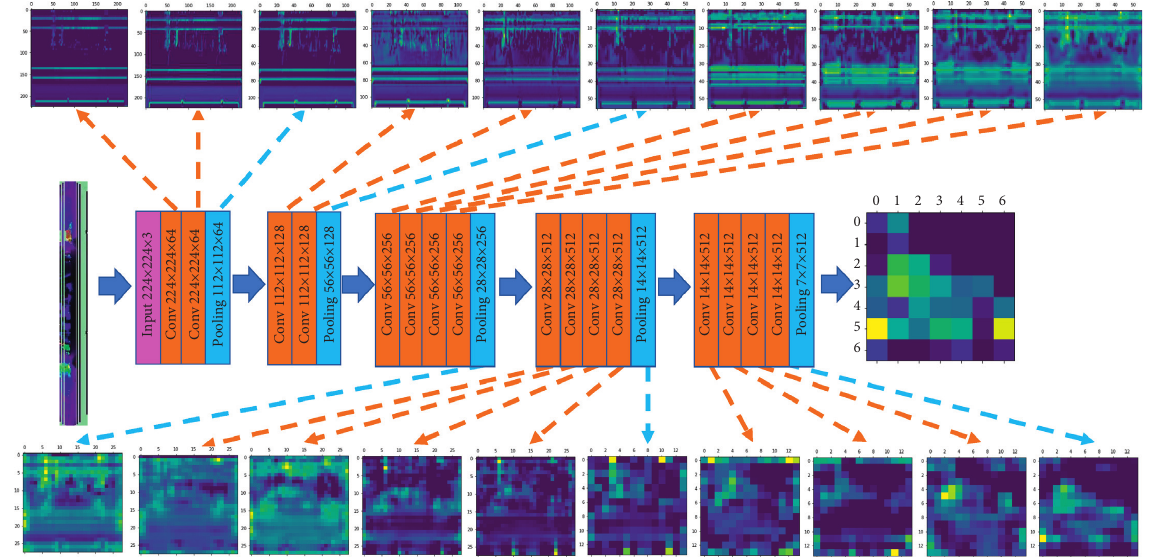
Figure 6: The process of the improved VGG19 network extracting feature map of point cloud front depth